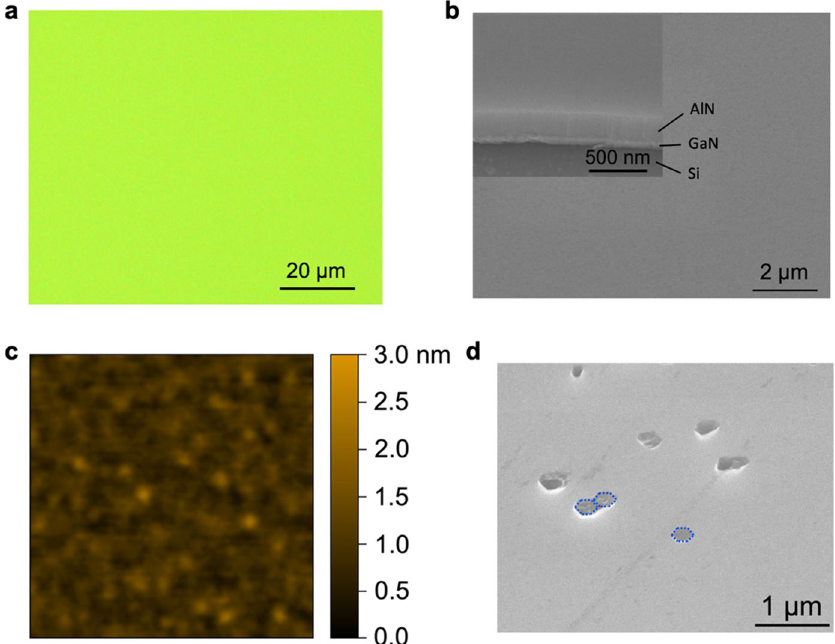
Figure 2. ( a ) An optical image showing the surface of the as-grown AlN epilayer. ( b ) SEM images of the as-grown AlN epilayer. Inset: An image highlighting the cross-section. ( c ) An AFM image of the surface of the as-grown AlN epilayer. The image size is 10 μm × 10 μm. ( d ) An SEM image showing the surface of the etched AlN epilayer by KOH. The dashed lines denote the hexagonal shapes and the network of hexagonal